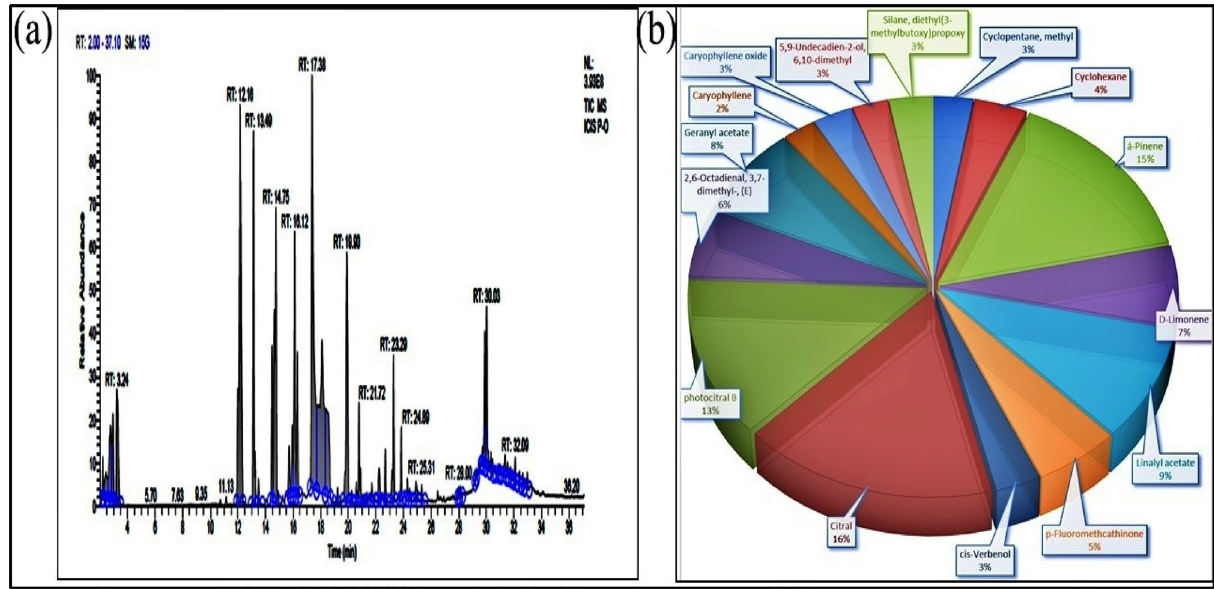
Figure 1. ( a ) Total ion chromatograms of GC–MS, ( b ) Percentage chemical composition of essential oil of C. flexuosus from site I—Palampur